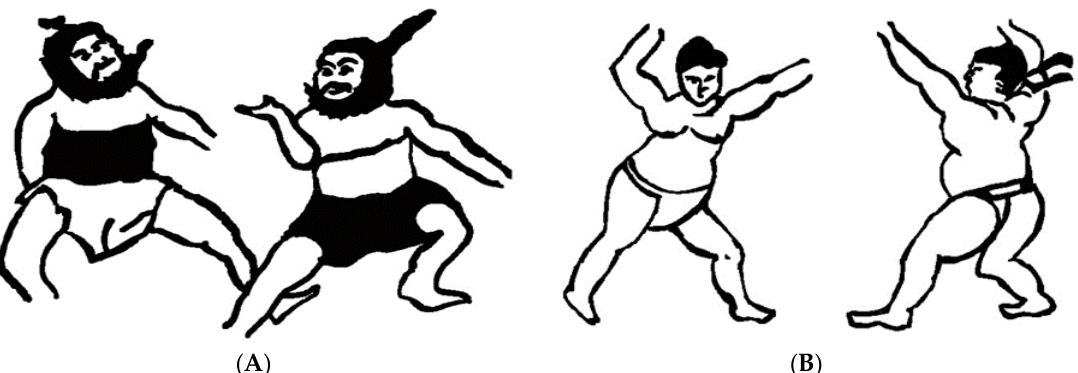
Figure 21. ( A ) Part of a mural painting depicting the scene of Jiaodi. The Han Dynasty. Sketched by author. Picture source: Liu (1985), p. 9. ( B ) Part of a silk painting depicting the scene of Jiaodi. The Tang Dynasty. Sketched by author. Picture source: Liu (1985), p. 10.